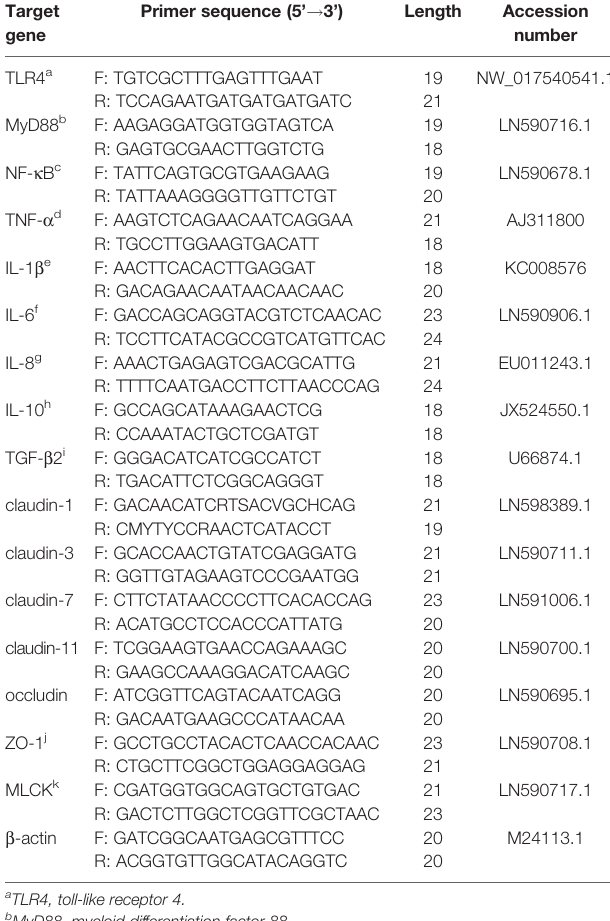
TABLE 2 | Real-time PCR primer